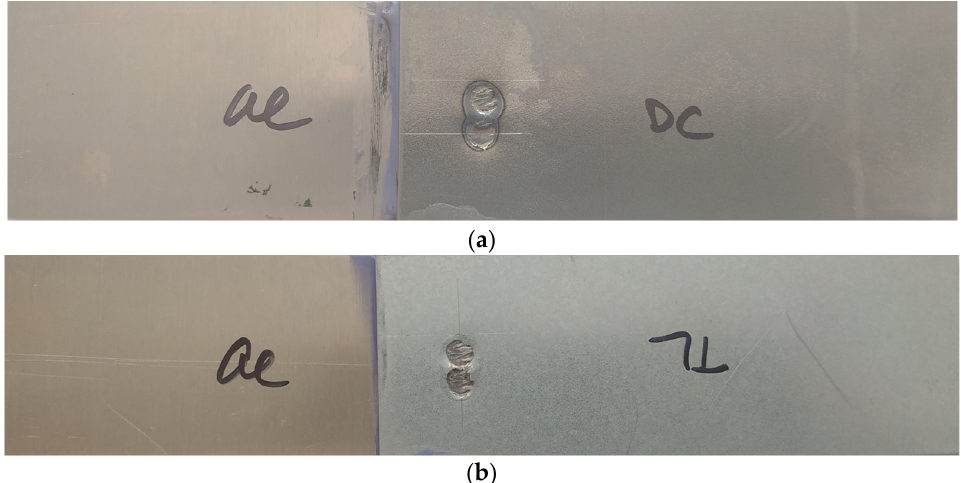
Figure 15. Appearance of test joints made by resistance spot welding and AB: ( a ) Al-DC and ( b ) Al-TL, epoxy based adhesive.